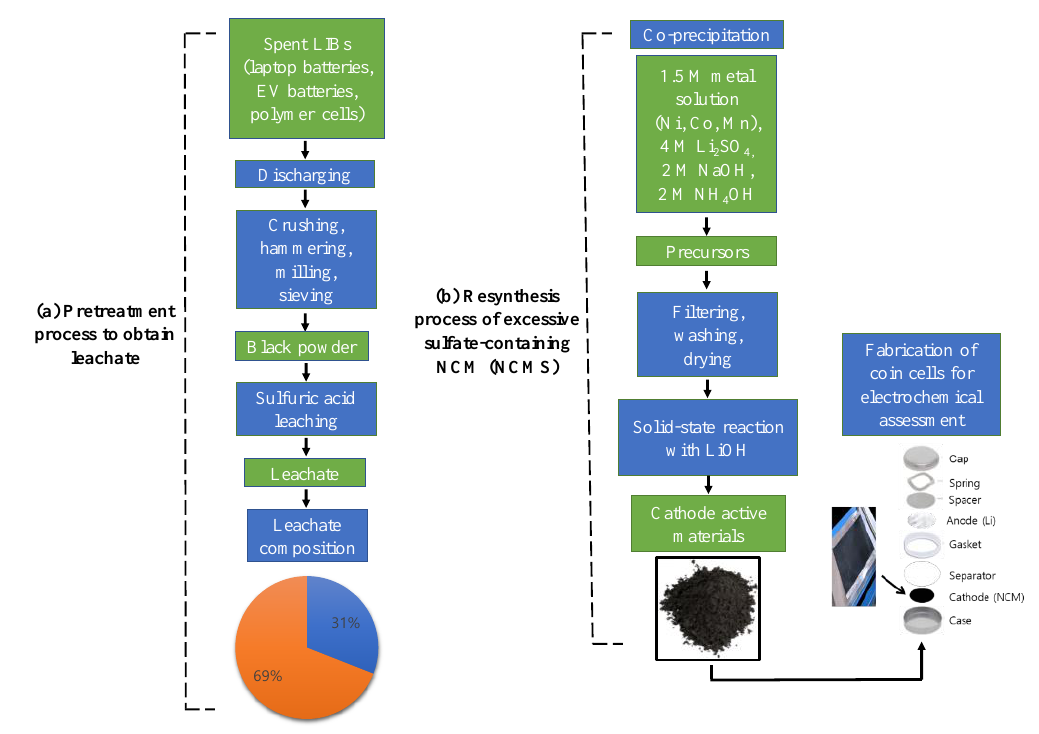
Figure 1. Flowchart of methodology for the resynthesis of excessive sulfate-containing NCM from spent LIBs. ( a ) Typical pretreatment process of spent LIBs with subsequent acidic leaching process using H 2 SO 4 , indicating the excessive sulfur content in leachate. ( b ) Synthesis process of sulfate-containing NCMS(OH) 2 precursors using the co-precipitation method and NCMS cathode active materials via a solid-state reaction, followed by a fabrication of coin cells for electrochemical assess- ment.